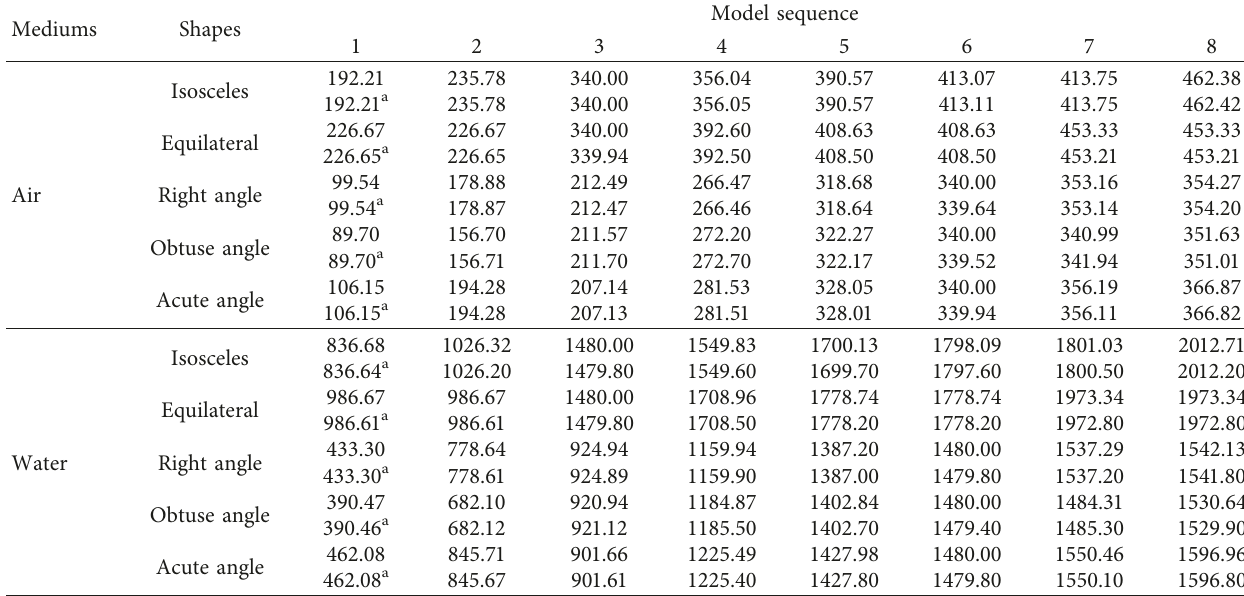
Table 3: The first eight natural frequencies (Hz) of triangular prism acoustic cavities with different shapes.